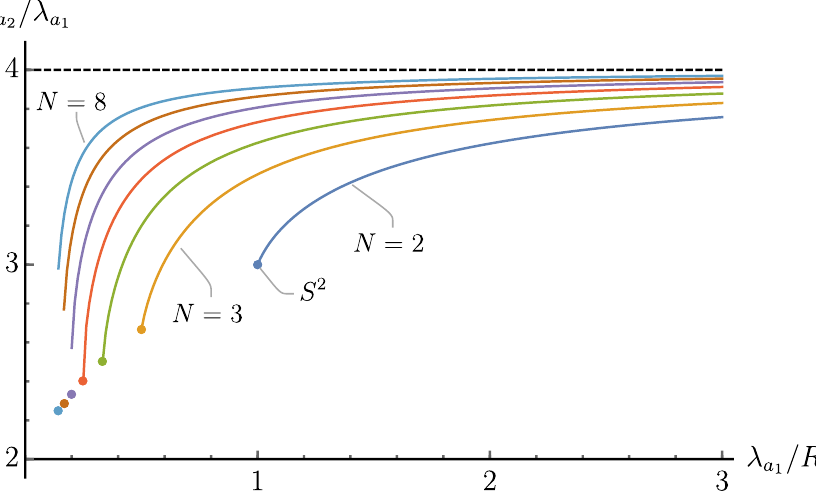
Figure 4 . Upper bounds on the ratio of the (cid:12)rst distinct nonzero eigenvalues of the scalar Lapla- cian for closed Einstein manifolds with R > 0 and N = 2 ; : : : ; 8, assuming that the Lichnerowicz eigenvalues satisfy eq. (2.16). These bounds apply to closed Einstein manifolds that admit Killing spinors, such as Einstein-Sasaki manifolds. The (cid:12)lled circles correspond to S N . closed Einstein manifolds with R > 0 and N = 2 ; : : : ; 8 when (cid:21) in eq. (2.16), the lower bound implied by the existence of a Killing spinor. We also